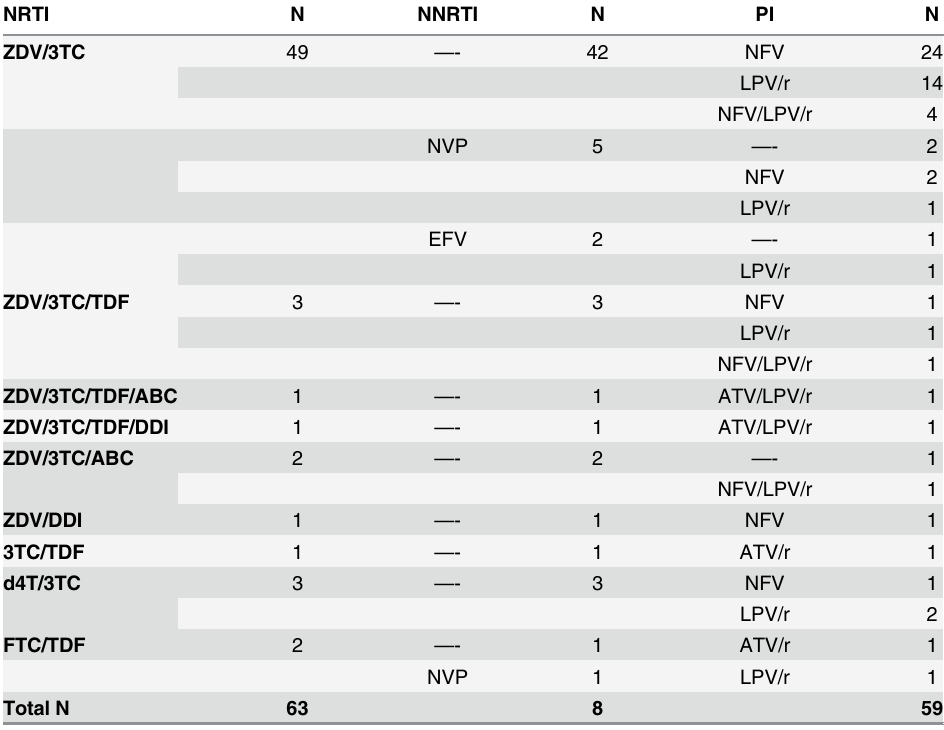
NRTI, nucleoside reverse transcriptase inhibitor; NNRTI, non-nucleoside reverse transcriptase inhibitor; PI, protease inhibitor; ZDV, zidovudine; 3TC, lamivudine; TDF, tenofovir; ABC, abacavir; ddI, didanosine; d4T, stavudine; FTC, emtricitabine; NVP, nevirapine; EFV, efavirenz; NFV, nel fi navir; LPV, lopinavir; NFV, nel fi navir; ATV, atazanavir; r, ritonavir